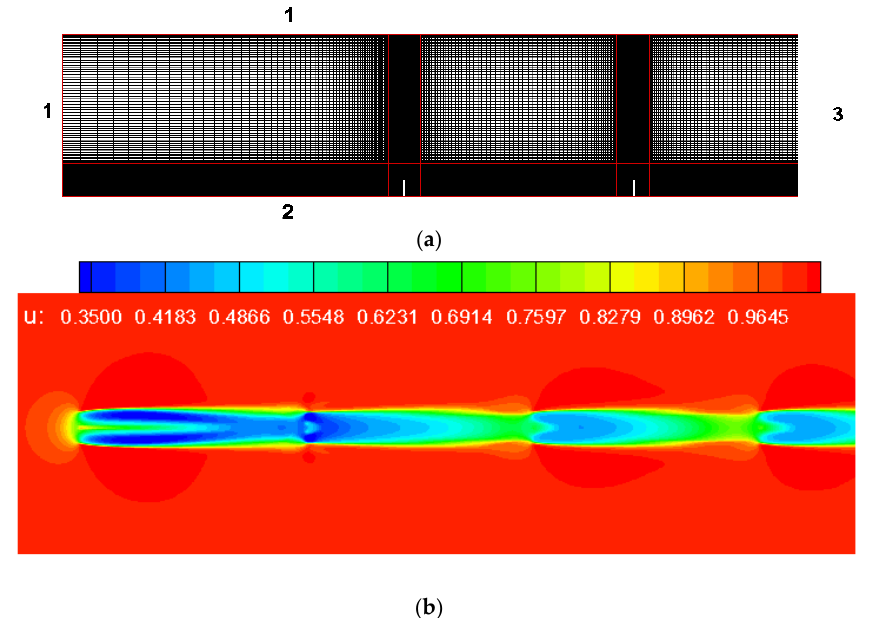
Figure 9. ( a ) Mesh topology; ( b ) stream-wise flow with multi-wakes.